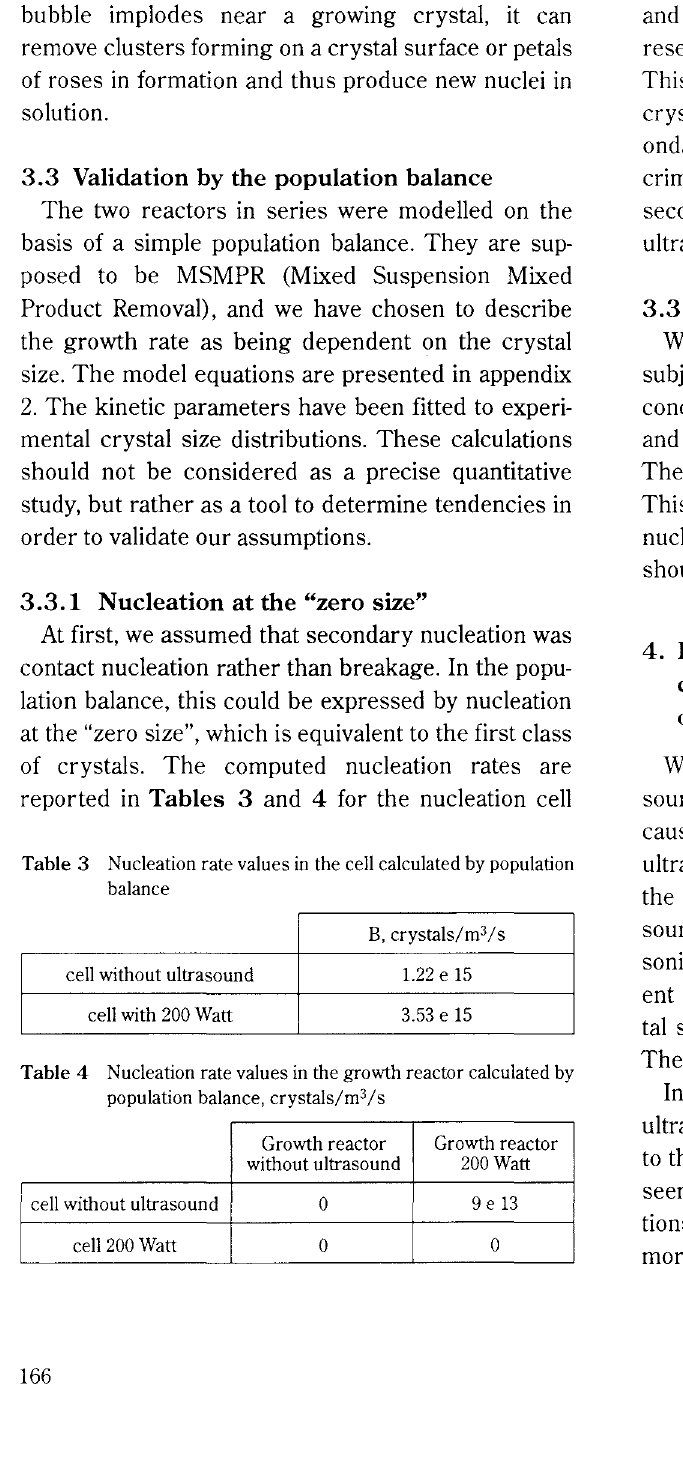
Fig. 10 Nucleation rate in the small cell as a function of the initial